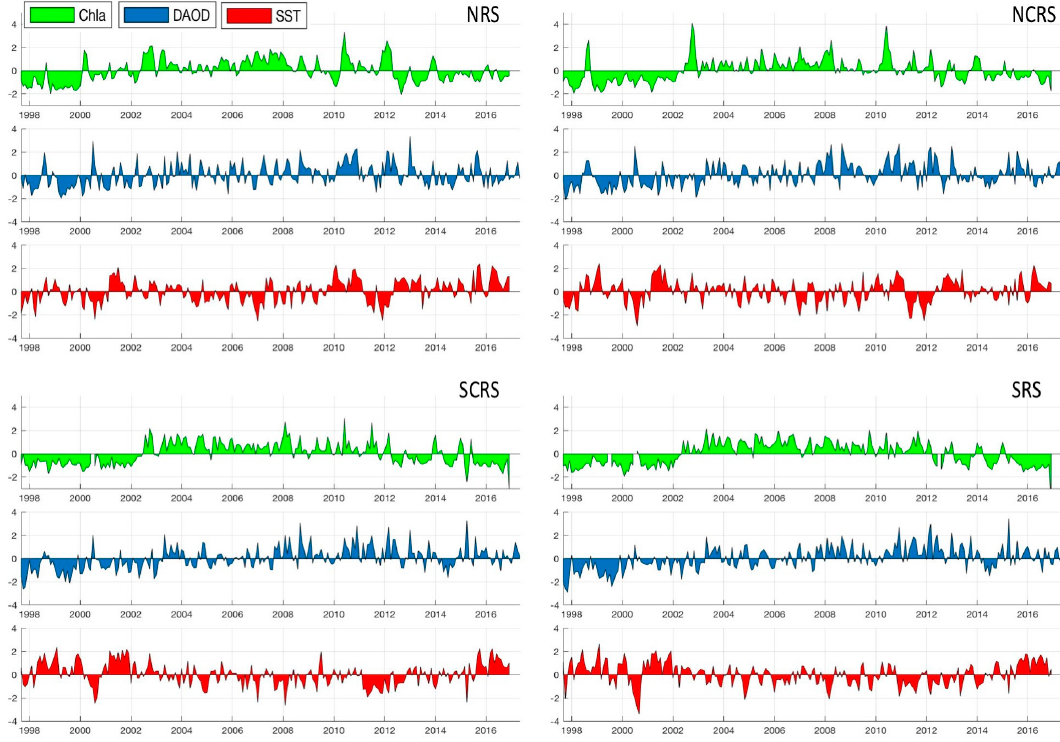
Figure 3. Time series of Z-scores (see Equation (3)) for Chl- a , DAOD (MERRA-2 Dust Scattering AOT in 550 nm), and SST for the four regions of the Red Sea represented in Figure 1.